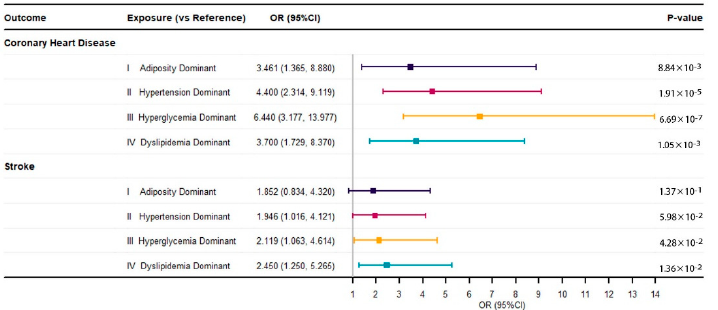
Figure 3. Estimates for the effects of metabolic subtypes on cardiovascular diseases *. * Odds ratios (ORs) and 95% confidence intervals (95% CIs) were estimated by multiple logistic regression mod- els adjusted for age, sex, and number of MetS components diagnosed.